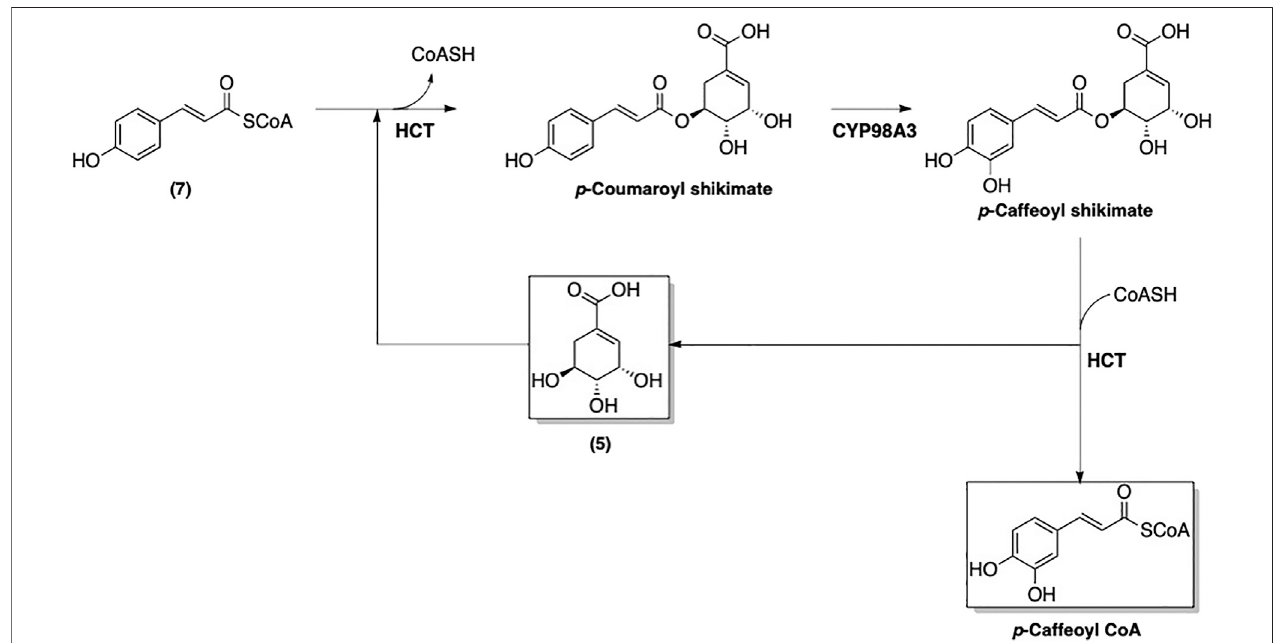
FIGURE 8 | Transformation of 4-coumaroyl CoA ( 7 ) into caffeoyl CoA.